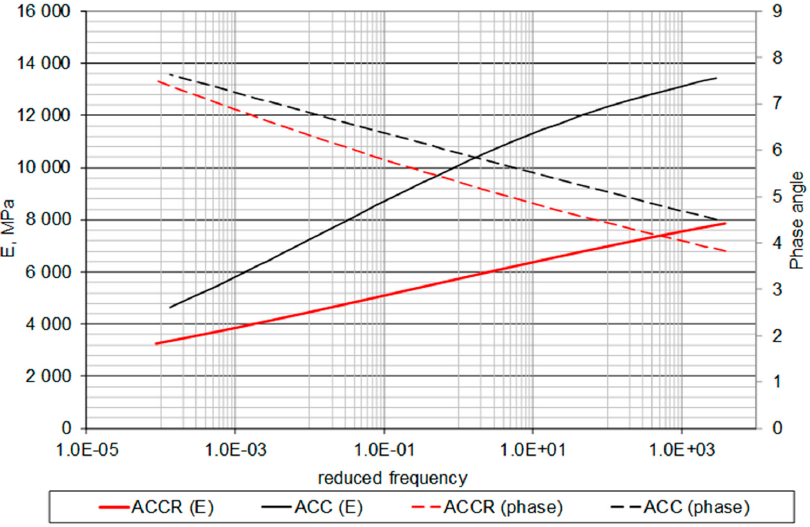
Figure 13. Master curves of stiffness modulus E and phase shift angle ϕ vs. reduced frequency for ACC with 20% of “B” CSR mortar and ACC with 20% cement-sand mortar (C:S = 1:1).